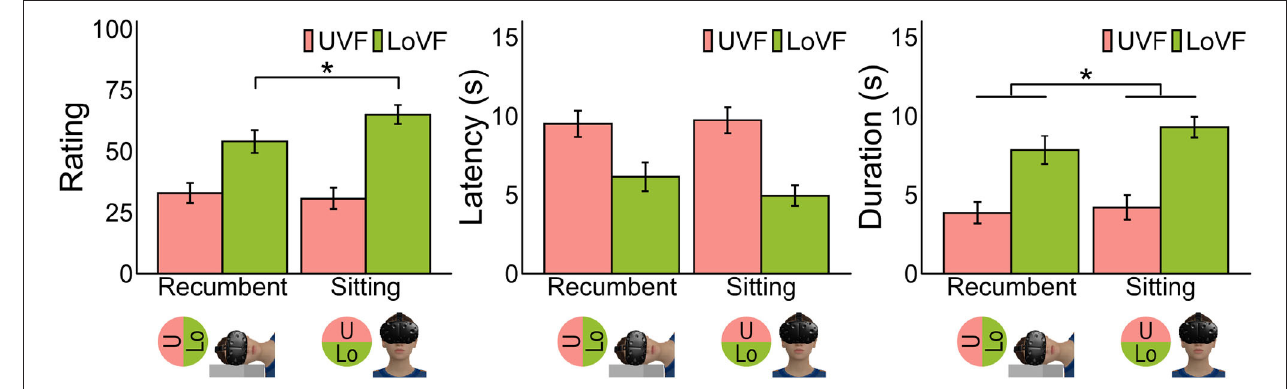
FIGURE 3 | Mean vection measures for each posture and vertical location of visual field. Error bars represent standard error of the mean. Pictures at the bottom illustrate each postural condition and VF. * p < 0.05.